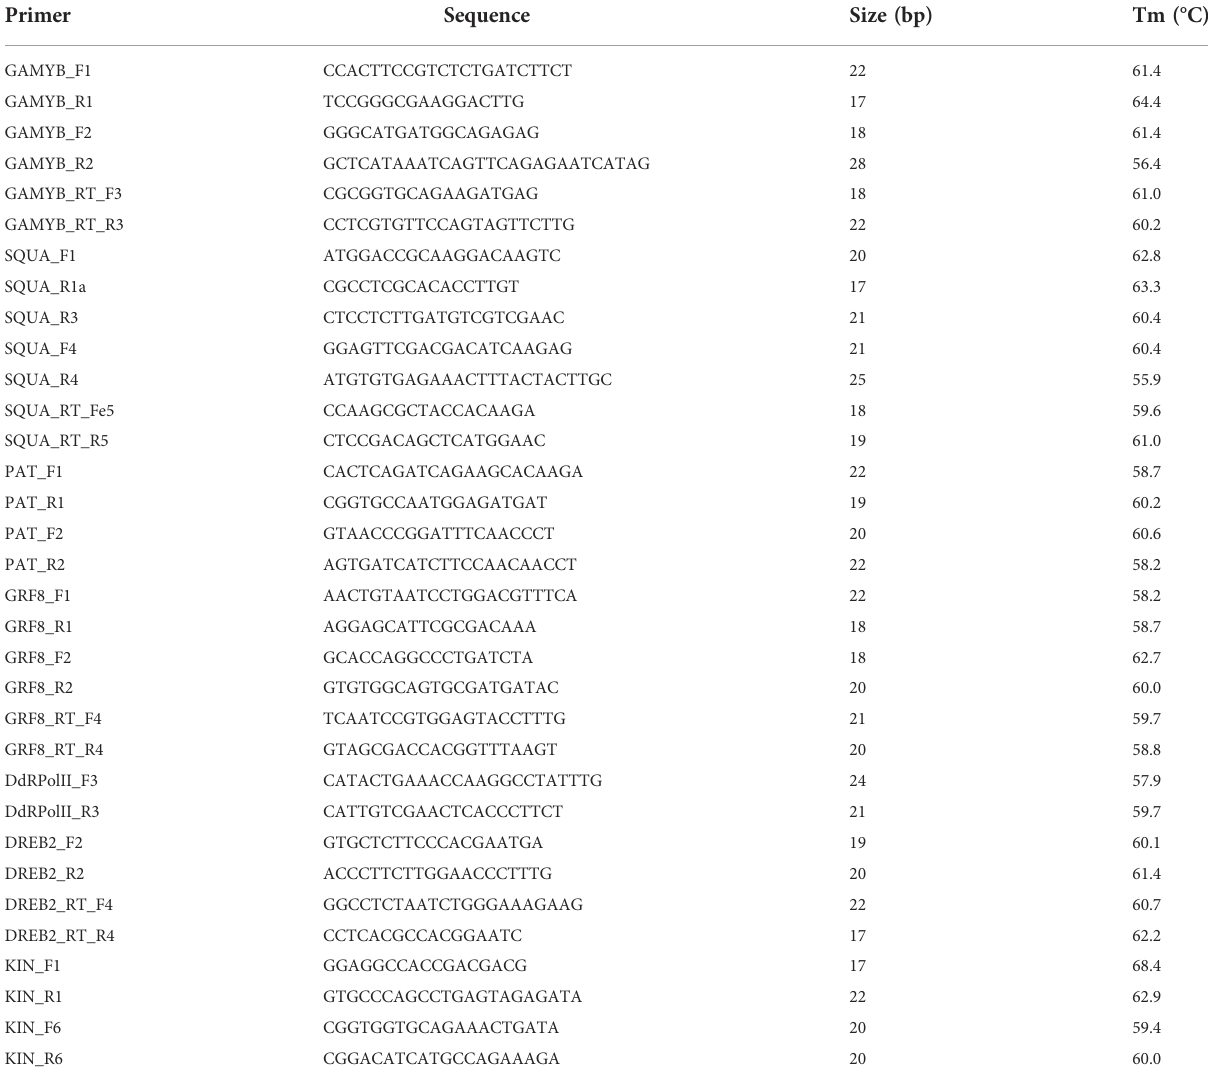
TABLE 2 Transcripts and/or gene based primers, designed for PCR and qPCR ampli fi cation. Primer